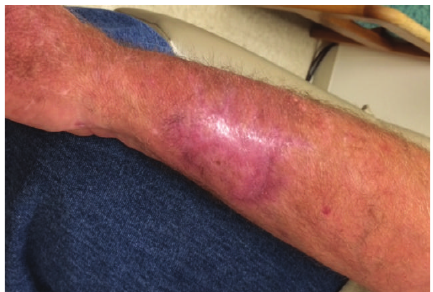
Figure2:Healedrightforearmlesion6monthsaftersymptomonset and at the conclusion of fluconazole therapy. The patient was seen in clinic 6 months after symptom onset and towards the end of the planned 6-month course of fluconazole therapy. Skin pigmentation changesremained,buttheulcerwasentirelyhealedandtherewasno pain or evidence of subcutaneous involvement. Follow-up clinical evaluation was notable for the absence of systemic symptoms and serial serum cryptococcal antigen remained